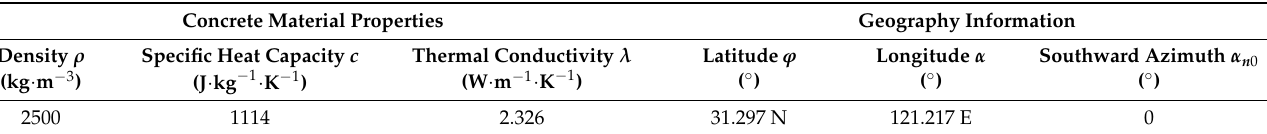
Table 1. Parameters and values adopted in FE model.